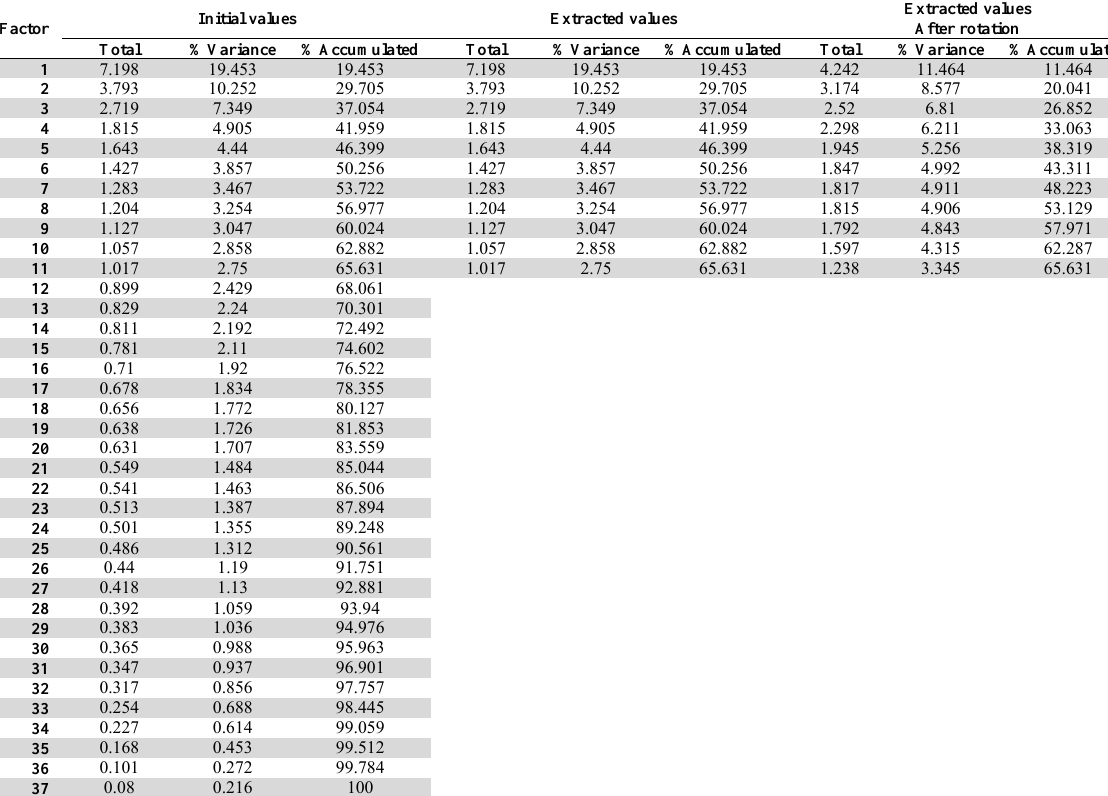
The summary of factor